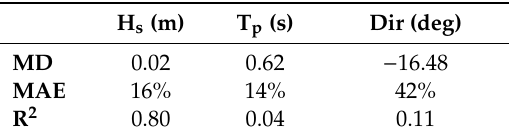
Table 2. Mean di ff erence (MD), mean absolute error (MAE) in percentage and R 2 values for calibration of wave parameters between measured and modelled results for Laguna Bay. While significant wave height (H s ) and peak period (T p ) values are reasonable, the calibration shows a distinct directional bias that represents an under-refraction of waves around the Noosa Headland.